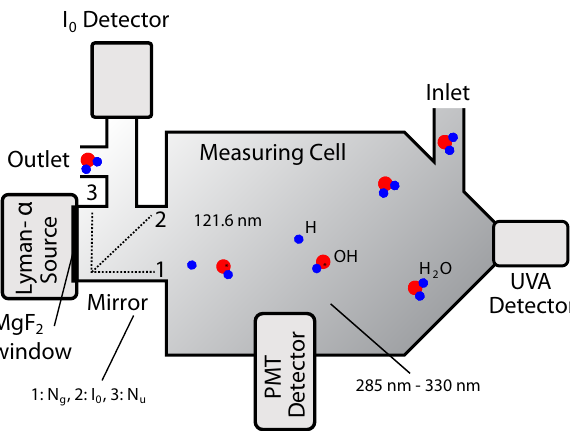
Figure 3. This diagram illustrates the principal setup of the Jülich calibration bench. The colored paths (green, dark and light blue) indicate the air flow through the system. Green and dark blue repre- sent the flow of dry and water saturated air, respectively. The user- defined, stable humidity level generated by mixing the dry and sat- urated air is colored in light